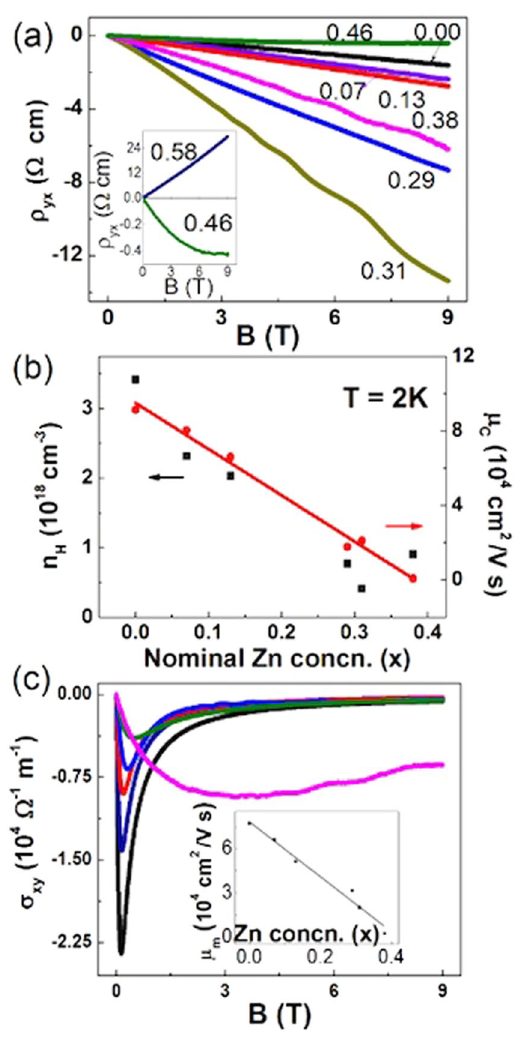
Figure 7. Panel (a): Field dependent Hall resistivity of (Cd 1 − x Zn x ) 3 As 2 for 0 ≤ x ≤ 0.46 at 2 K. From x = 0.00 to 0.46, all samples are n-type. Inset: The Hall resistivity of the sample for x = 0.46 shows a non-linear profile. For x = 0.58, the signal turns to p-type. Panel (b): Carrier density n H (n H = B/(e ρ yx )) and mobility μ c ( μ c = 1/ (e ρ xx n H )) at 2 K versus x for x = 0.00 to 0.38. Panel (c): The conductivity σ xy versus the magnetic field. Inset: The mobility got from the standard Bloch-Boltamann